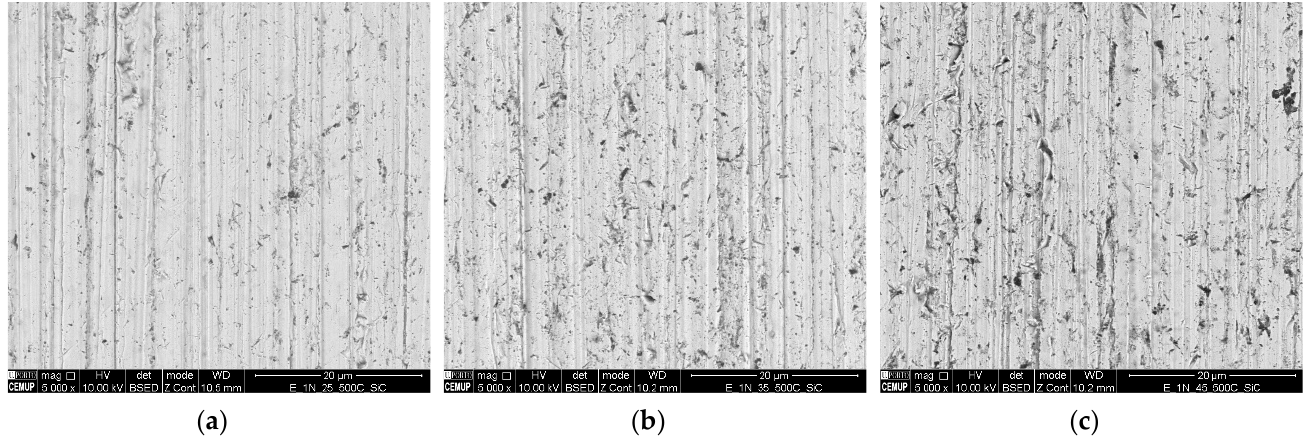
Figure 15. Analysis of the center of the ball tracks by SEM for abrasive SiC with a normal load of 1 N for ball etched 60 s: ( a ) (SC) 0.25 g/cm 3 ; ( b ) (SC) 0.35 g/cm 3 ; and ( c ) (SC) 0.45 g/cm 3 .